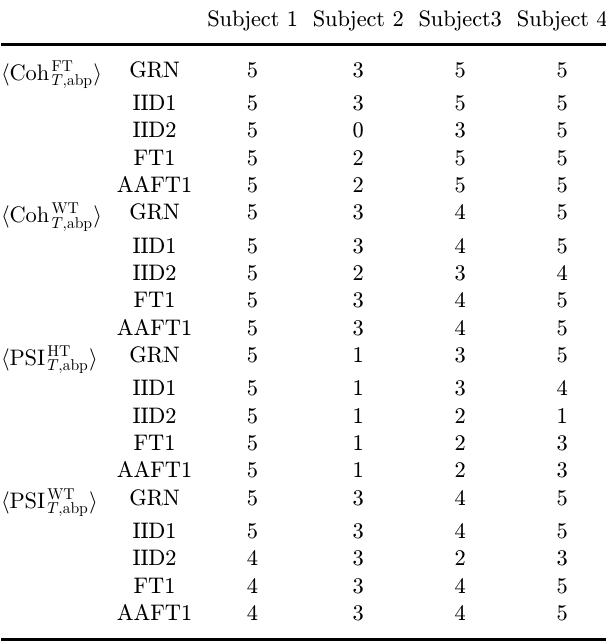
Table 1. Summary of the results reported in Figs. 3 – 6 about the signi¯cance of the four di®erent covariation metrics with ¯ve methods to generate surrogate